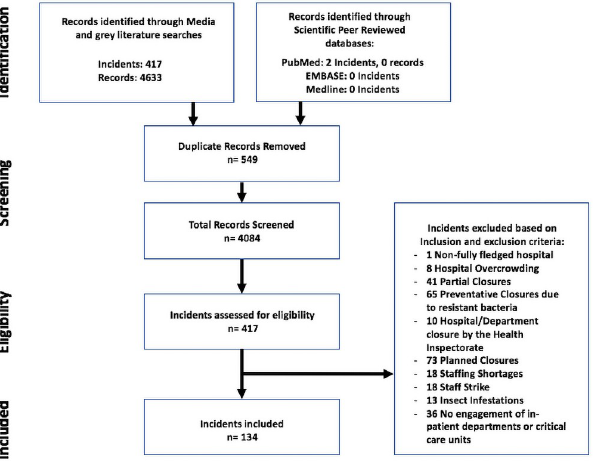
Fig 1. Flow diagram of the scoping review process. Process during the screening and identification of internal hospital crises and disasters in the Netherlands between 2000 and 2020.